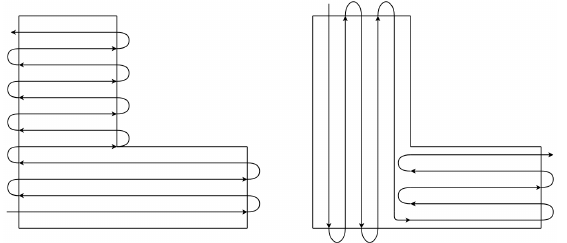
Figure 3. Coverage paths in a concave